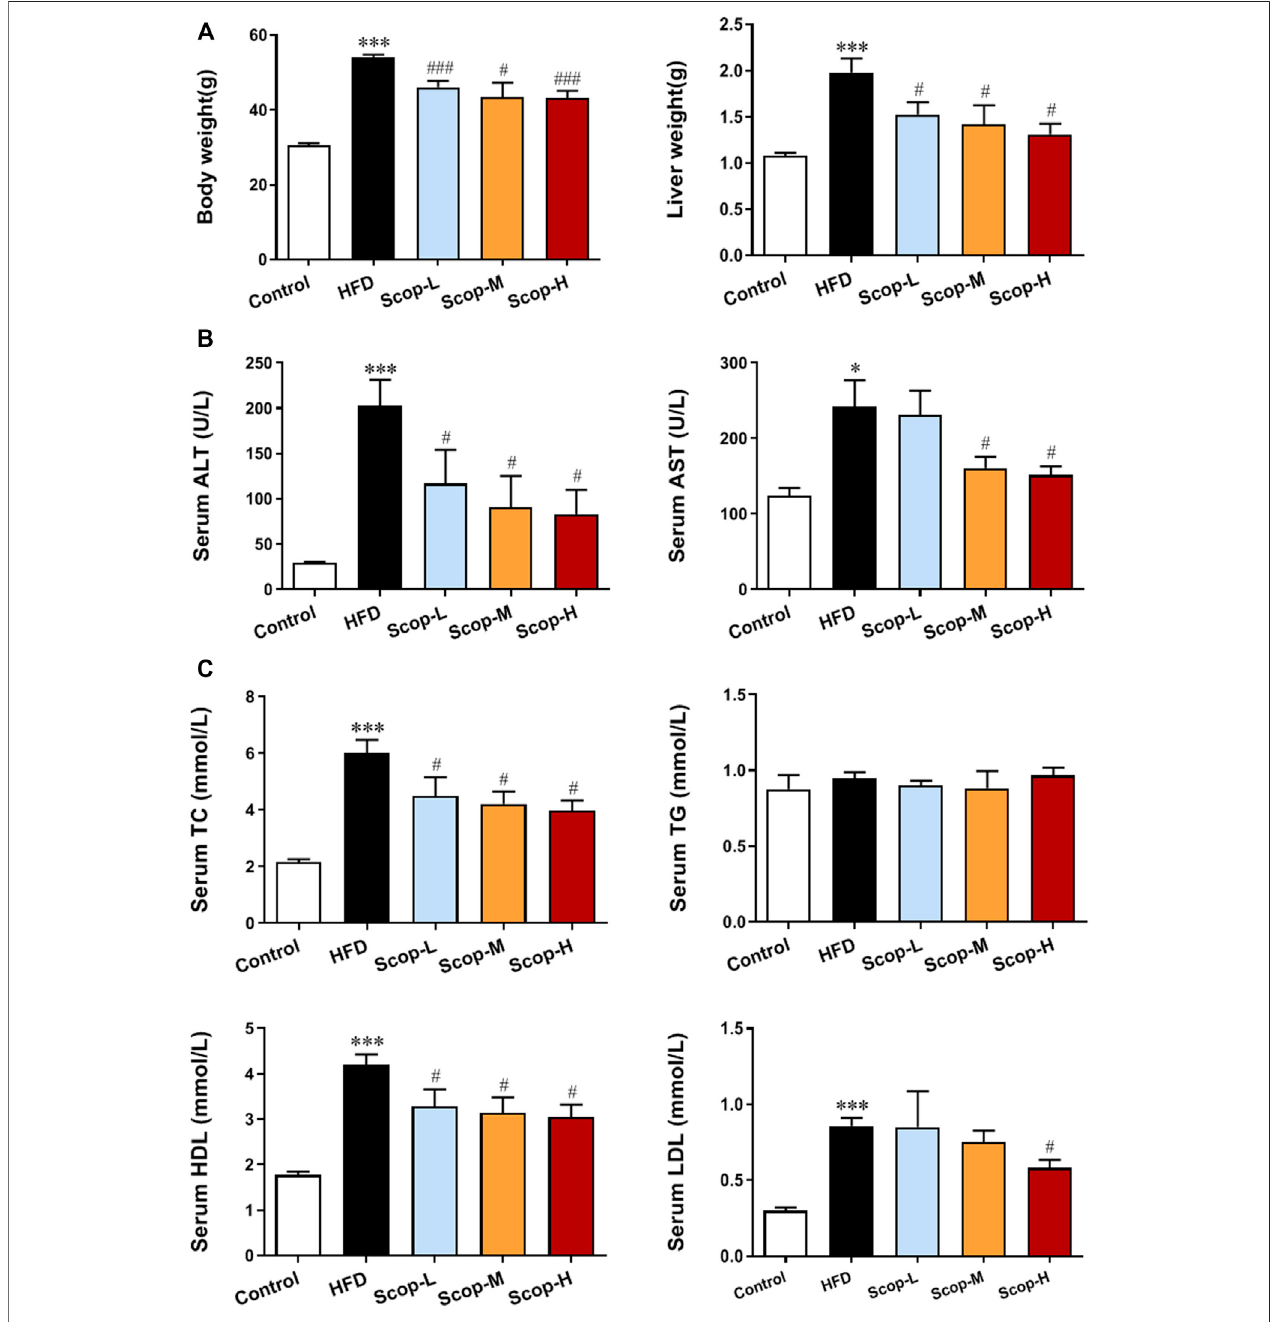
FIGURE 6 | Scoparone improved the body weight, liver weight and serum levels of lipid and aminotransferases in the HFD-induced NASH mice. (A) Body weight and liver weight of mice. (B) Serum lipid level. (C) Serum liver enzyme levels. * p < 0.05, *** p < 0.001 vs. Control; # p < 0.05 , ### p < 0.001 vs. Model.